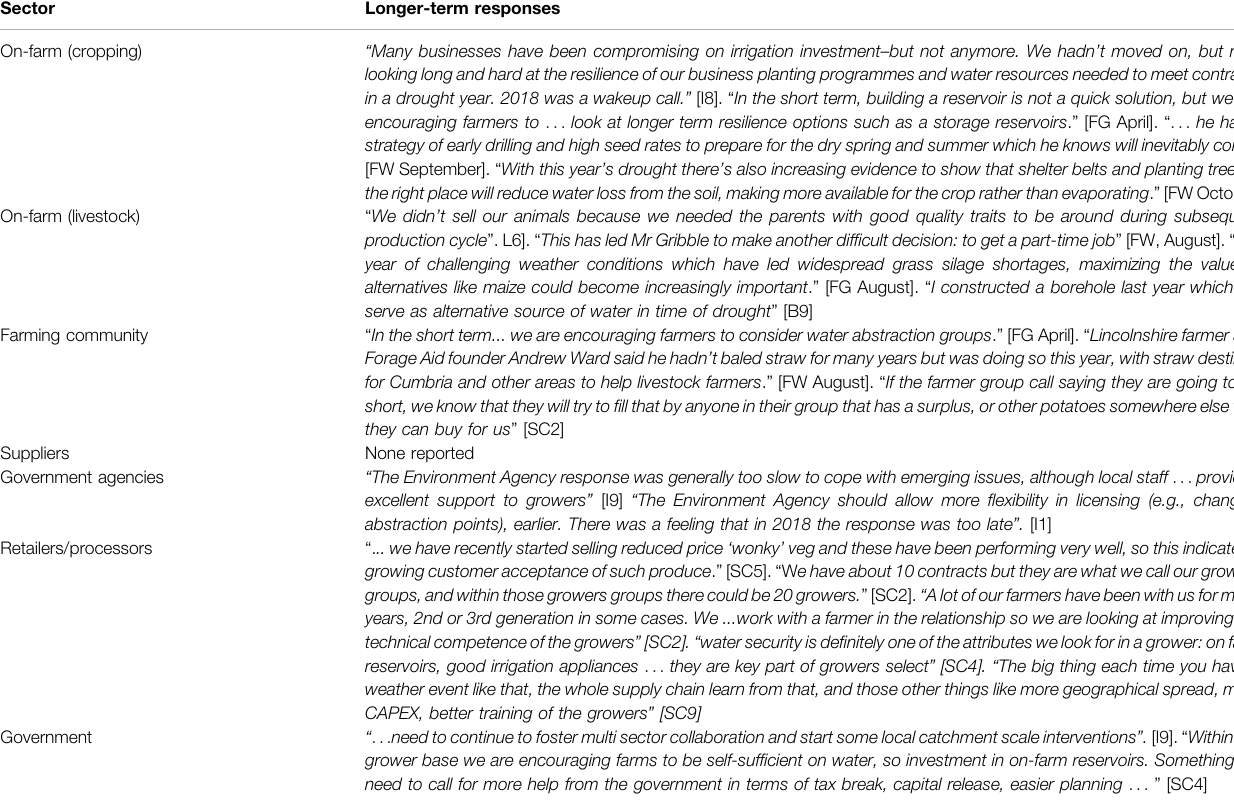
TABLE 2 | Exemplar reported longer-term responses to drought impacts across the farming sector.